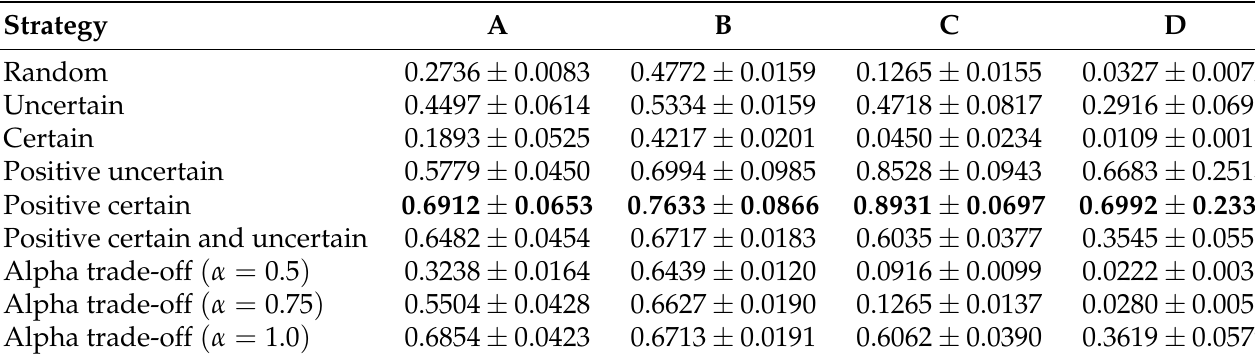
Table 8. Mean MAP score with standard deviation, aggregated over used models and representations, for each strategy, reported on each of the four datasets. The best score for each dataset is shown in bold. A–D correspond to the four datasets we used to conduct the experiments, which are described in Table 2.